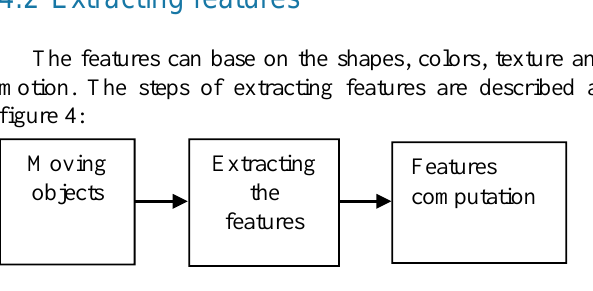
Figure 4: The steps of extracting features After extracting moving objects, we extract the features of objects. In here, we use two features: the shape-based features and the motion-based